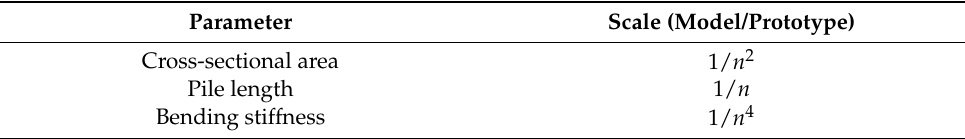
Table 1. Proportional relation between the model and prototype [61].